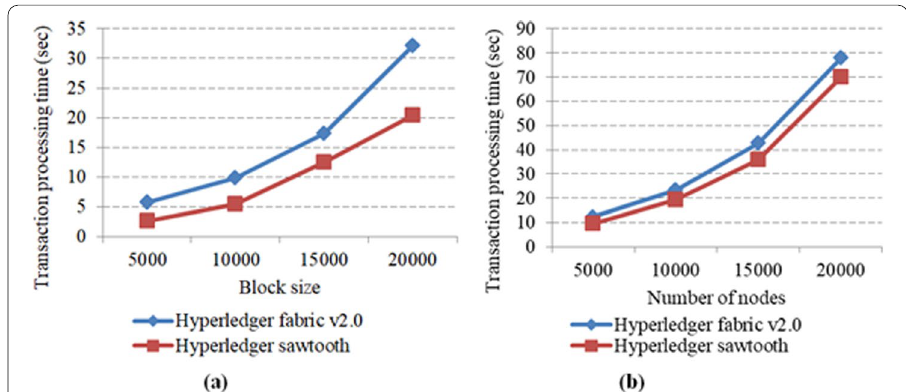
Fig. 11 Blockchain performance parameter transaction processing time: a different block size and b different number of nodes. Performance parameter transaction processing time of the blockchain is presented in graphical form. Transaction processing time required is tested by variation in block size and number of nodes. Transaction is nothing but operations executed by nodes for initialization and validation of blocks. a Transaction processing time of system when different block size is used in blockchain using Hyperledger fabric 2.0 and sawtooth is represented. b Transaction processing time of system when different number of nodes when same block size is used when implemented using Hyperledger v2.0 and sawtooth is graphically